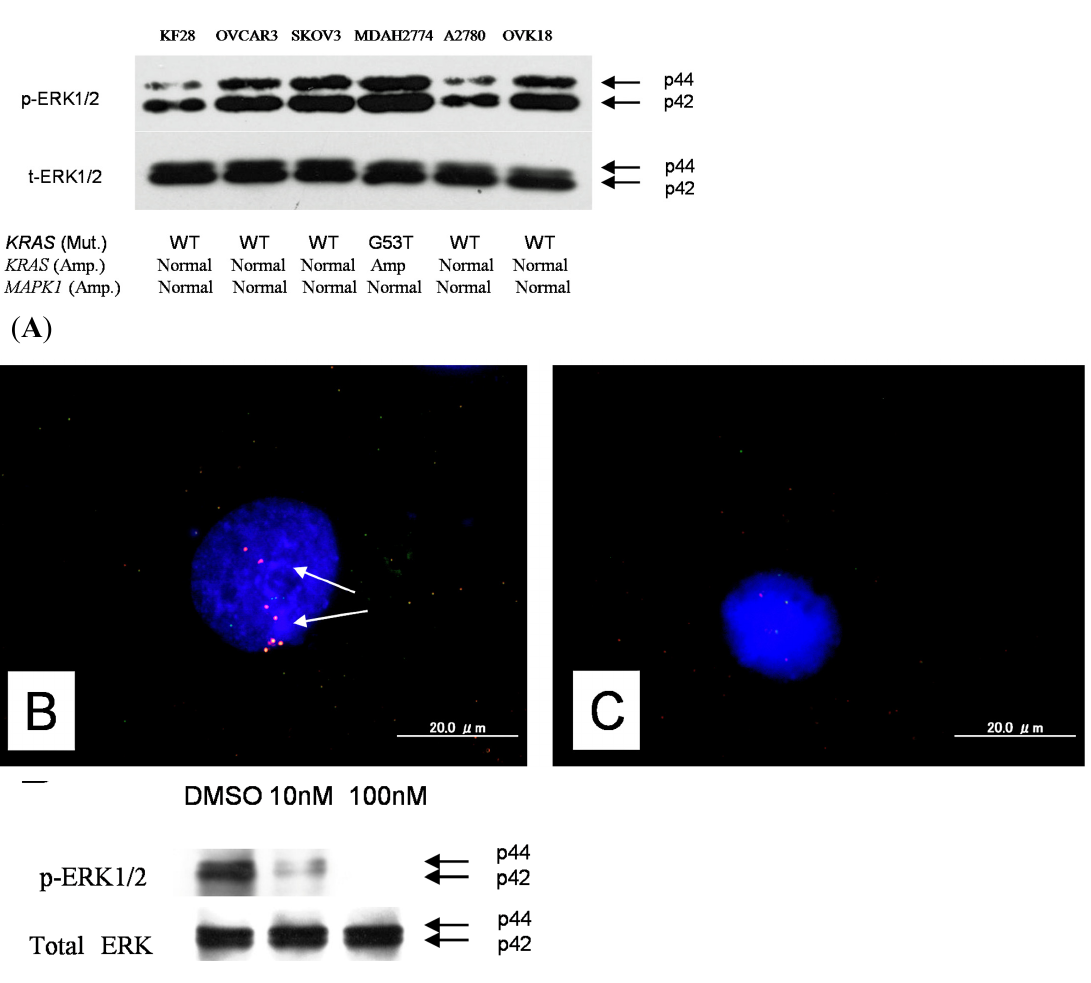
Figure 3. Western blot analysis. ( A ) Western blot analysis showed a higher level of p-ERK protein expression in MDAH2774 cells than in other cell lines; ( B ) Dual-color fluorescence in situ hybridization (FISH) validated amplification of the KRAS gene in ovarian cancer cell line (MDAH2774) White arrows indicate amplification of KRAS gene; ( C )